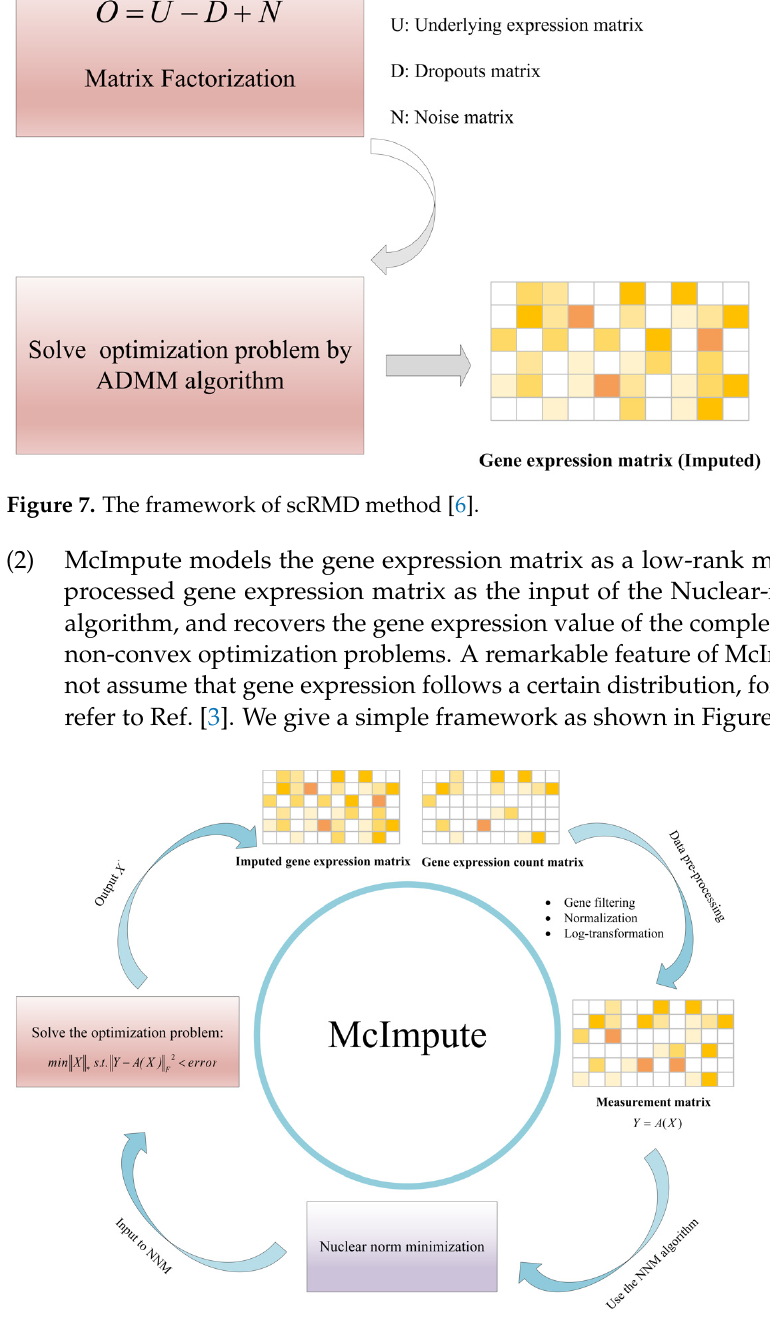
Figure 8. The framework of McImpute method [3].